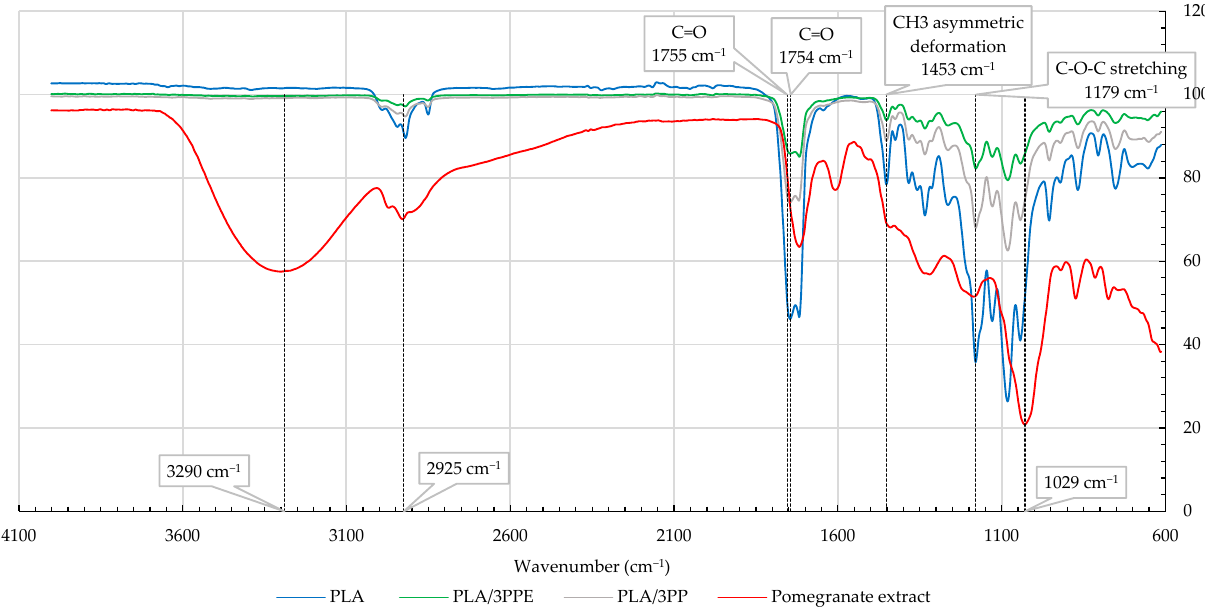
Figure 1. FTIR spectrum of the pomegranate extract (PPE-FD), control (PLA), and active films (PLA/3PPE and PLA/3PP).